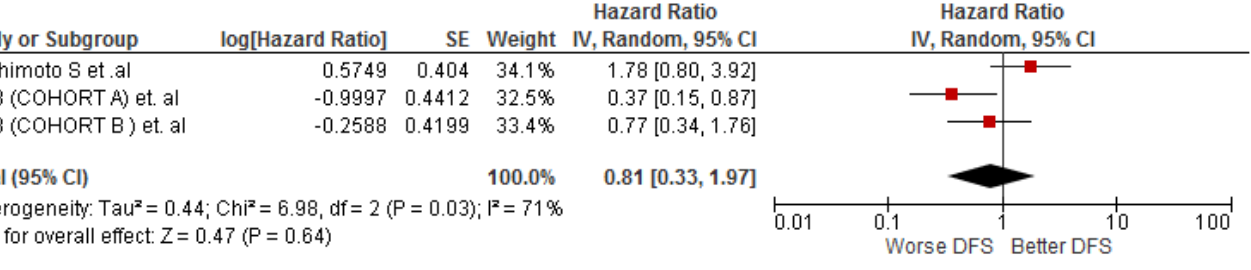
Figure 3. Association of LMR and DFS in patients with cholangiocarcinoma.